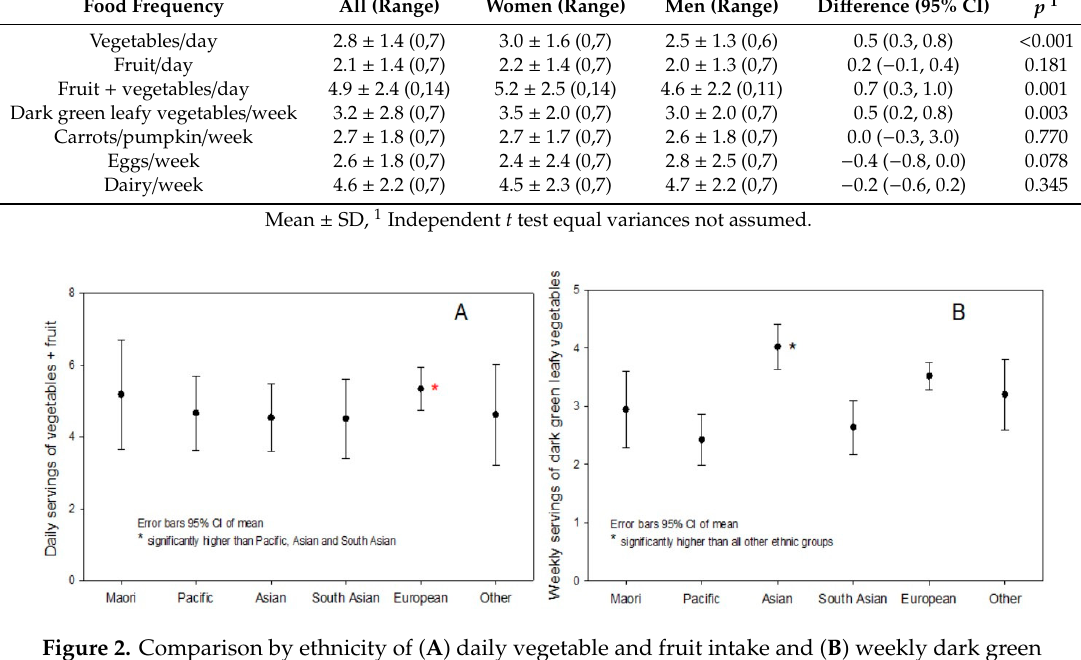
Figure 2. Comparison by ethnicity of ( A ) daily vegetable and fruit intake and ( B ) weekly dark green leafy vegetable intake.